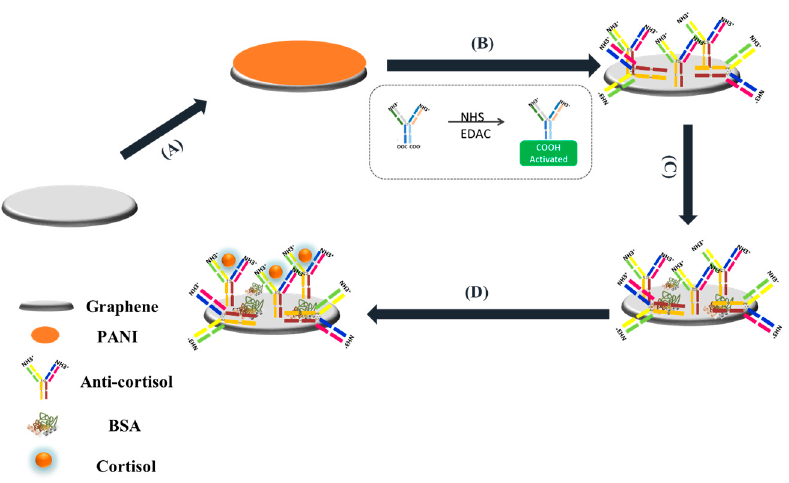
Figure 1. Schematic of the immunosensor assembly.